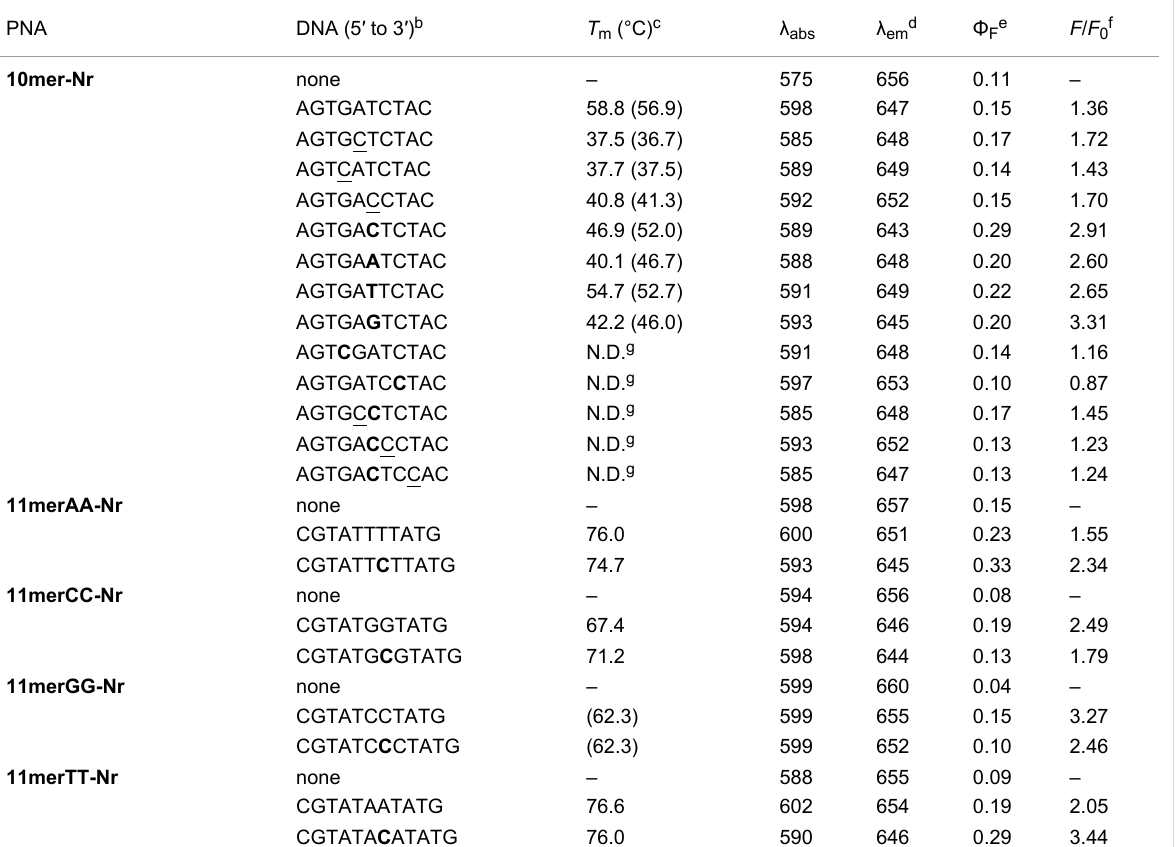
Table 2: T m and optical properties of Nile red-labeled acpcPNA a . PNA